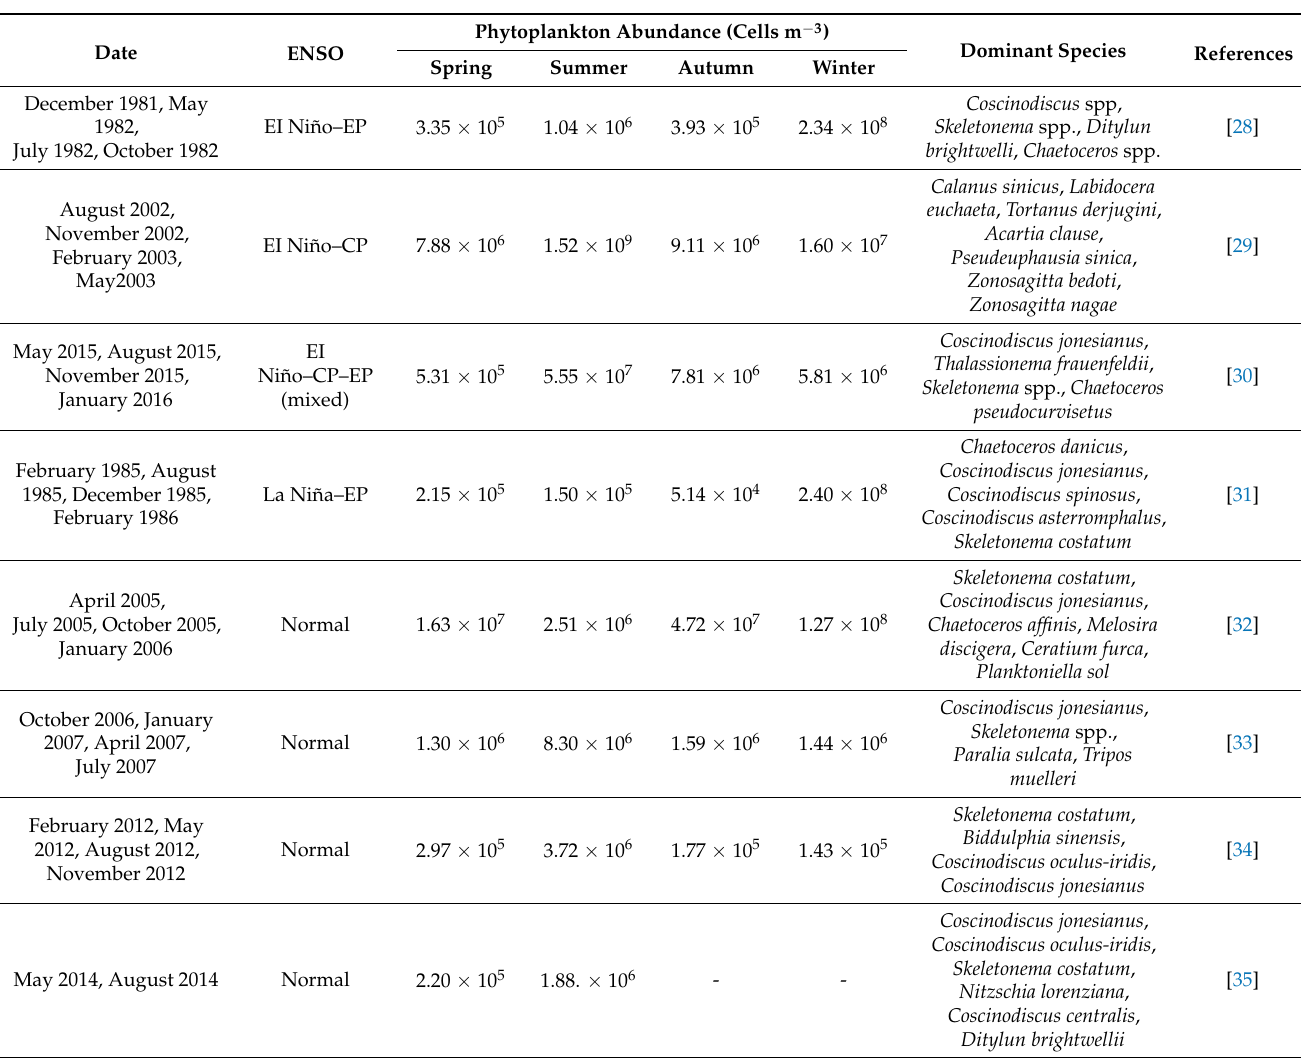
Figure 1. Location of Sampling stations in Sanmen Bay (red, grid station; blue, time serials station; green, sediment sampling station). Table 1. Location parameters of phytoplankton net sampling stations in Sanmen Bay from 2016 to Table 2. Historical phytoplankton data from Sanmen 2017.